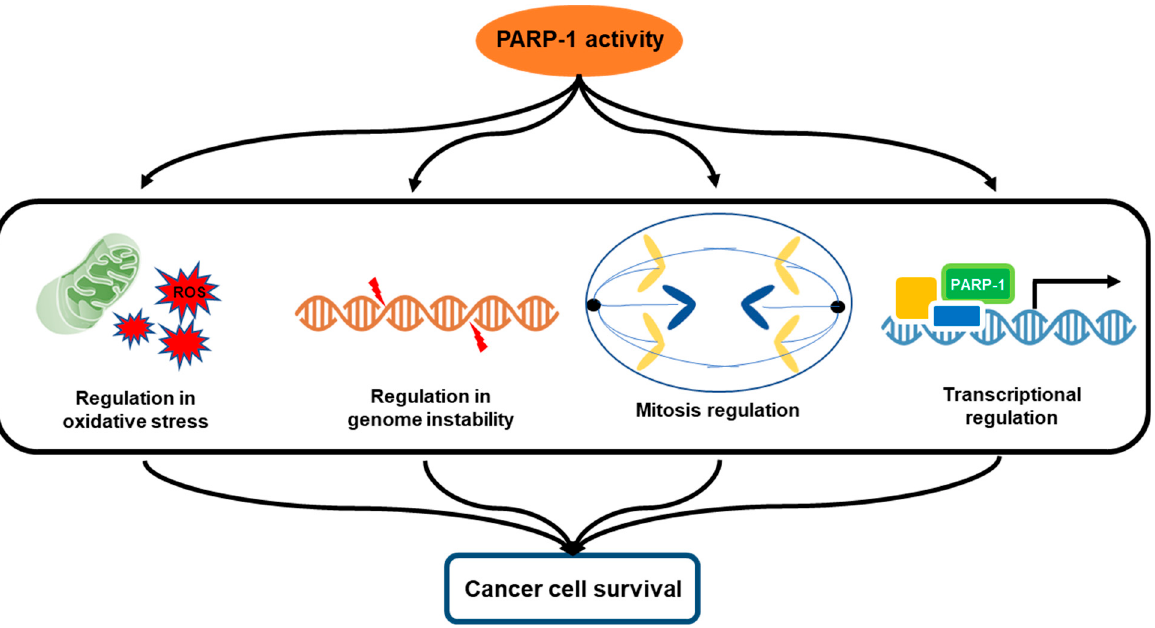
Figure 1. Multifactorial role of poly (adenosine diphosphate (ADP)-ribose) polymerase-1 (PARP-1) in cancer cell survival. PARP-1 can occupy a position as an important regulator of mitochondrial superoxide and oxidation, and it is required for the dysfunctional regulation of the cell cycle and cell proliferation that has a crucial role in tumorigenesis. Moreover, PARP-1 can modulate histone proteins, epigenetic markers, and chromatin structure related to transcriptional regulation and DNA repair under genome instability. Therefore, PARP-1 has critical relevance to the development and malignant transformation of pancreatic cancer.